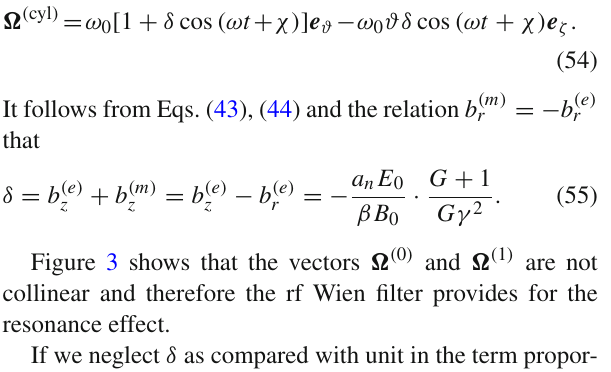
rf electric-field flipper and the rf Wien filter (containing the same rf electric-field flipper). While the difference is small, it is crucial for the establishment of consent between analytical derivations and computer